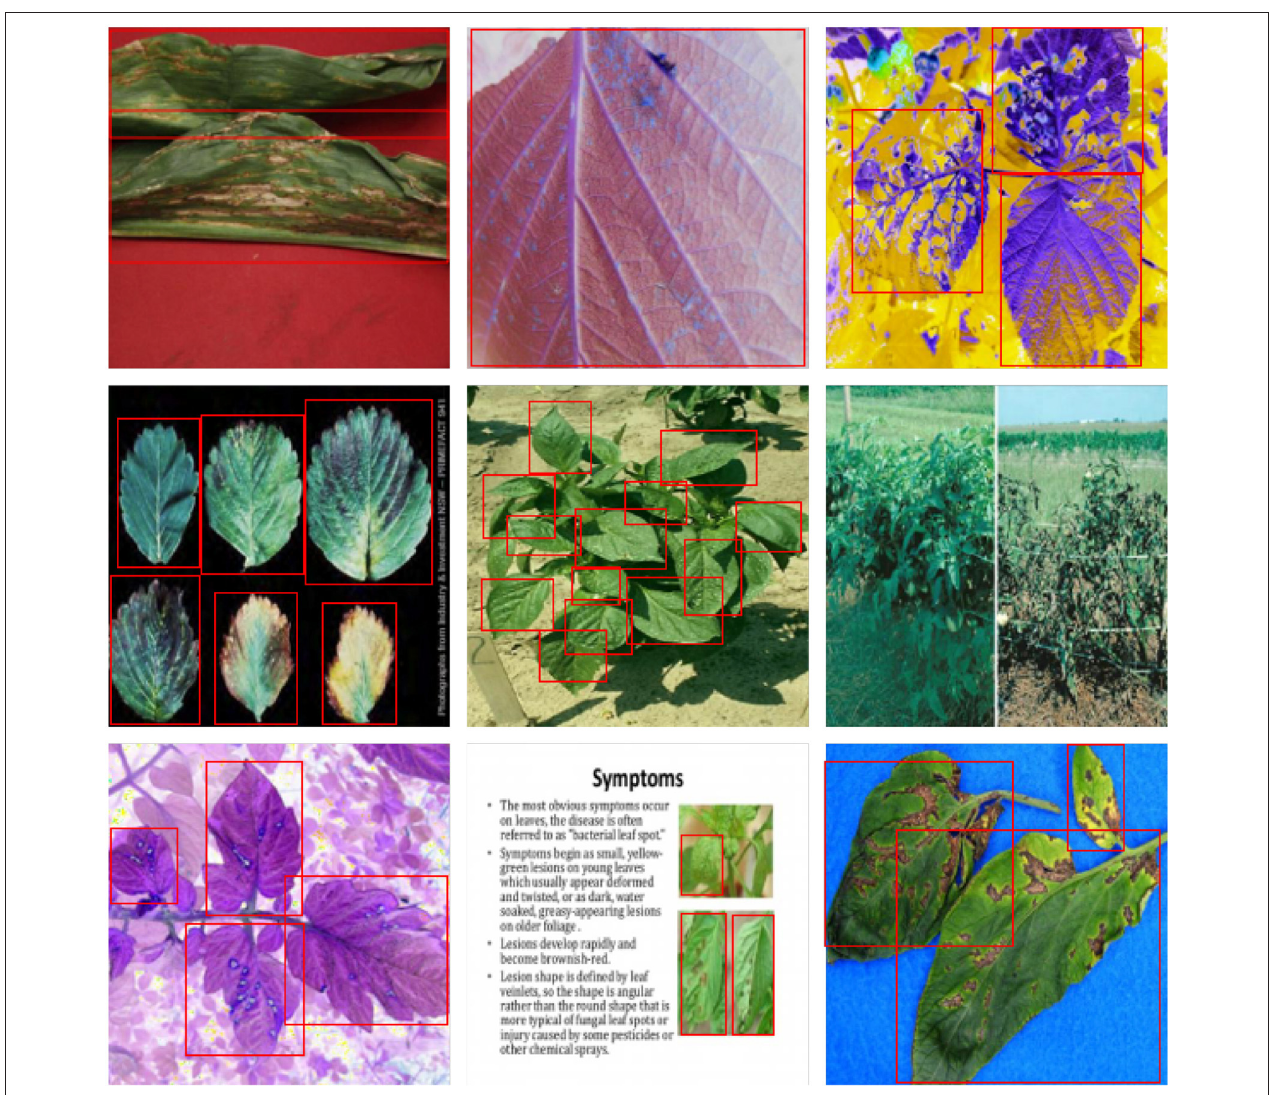
FIGURE 10 | The detection results of our model in the dataset.